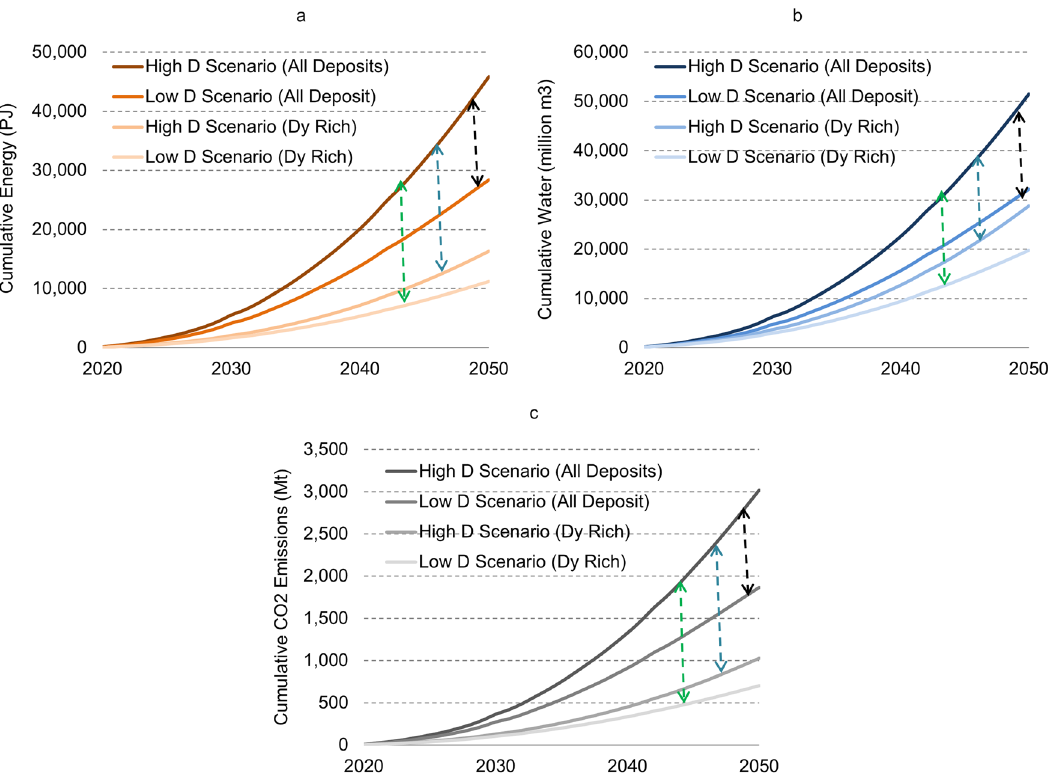
Fig. 9 Total energy, water, and CO 2 emissions associated with both oversupplied REEs and Dy and Nd production in two demand scenarios and two primary supply scenarios. Cumulative a energy, b water, and c CO 2 emissions associated with the oversupplied REEs and the production of Dy and Nd in the high and low demand scenarios and two primary supply scenarios. The black dotted line represents the reduction due to resource use ef fi ciency (MC changing scenario compared to MC constant scenario, the blue dotted line represents the reduction due to the supply from Dy rich deposits instead of the supply from all deposits, and the green dotted line represents the reduction due to both resource use ef fi ciency and the supply from Dy rich